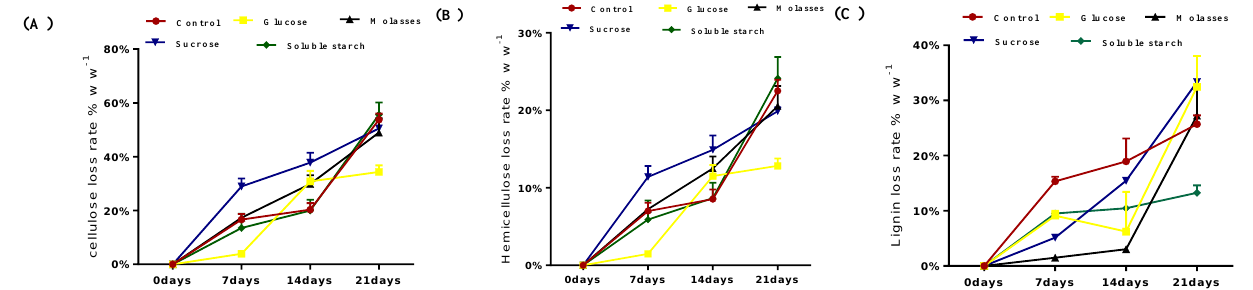
Figure 1. Loss rate of cellulose, hemicellulose, and lignin from corn stover during 21 days of solid−state fermentation with Phanerochaete chrysosporium. ( A ) Cellulose loss rate. ( B ) Hemicellulose loss rate. ( C ) Lignin loss rate.